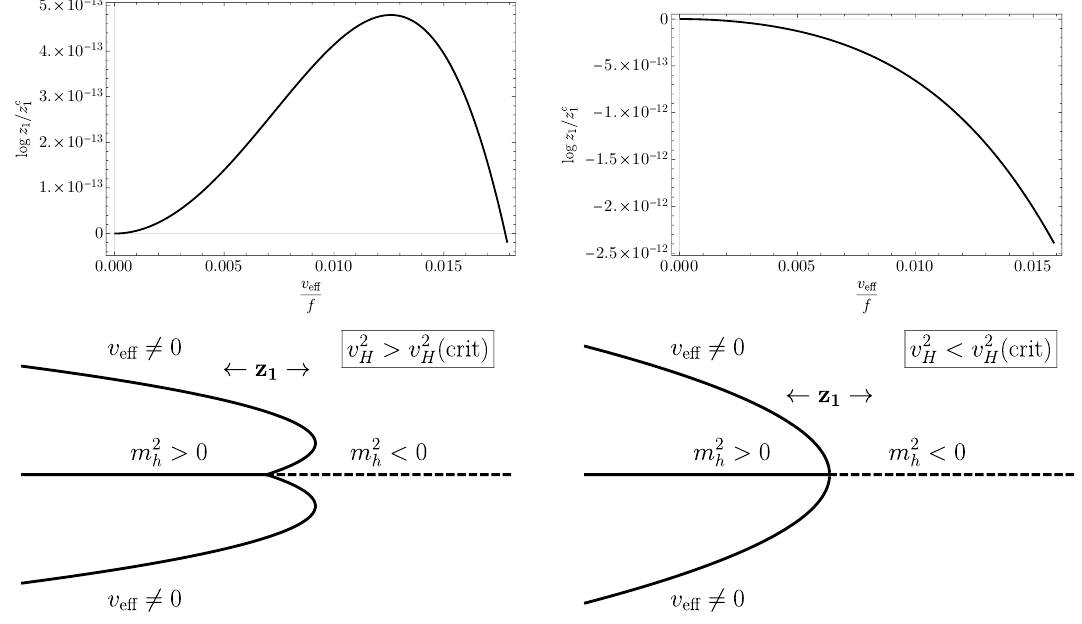
Figure 5. In this plot, we show the e(cid:11)ective VEV as a function of z 1 . On the left, we show it for a value of v 2 that is very close to \critical," but with v 2 > v 2 (crit). In this case, for small Higgs vev, H H H z 1 > z c . On the right, we display it for v 2 more negative than the critical value, and in this case, H for all values of the Higgs VEV, we (cid:12)nd z 1 < z c . We also sketch the \bifurcation" diagrams for each of these scenarios as a function of z 1 , where the solid lines represent the stable scalar con(cid:12)gurations and the dashed line represents the background solution with unresolved tachyon(s). The branching point corresponds to z 1 = z c